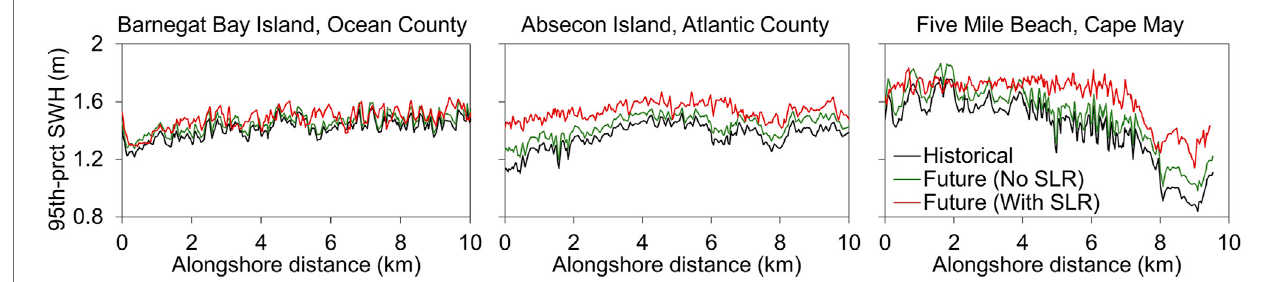
FIGURE 9 | 95th-percentile SWH at a water depth of about 2.5 m along the shore of three selected barrier islands. Distances are measured from south to north along each barrier island (the origin of distance is the southmost point of each island).